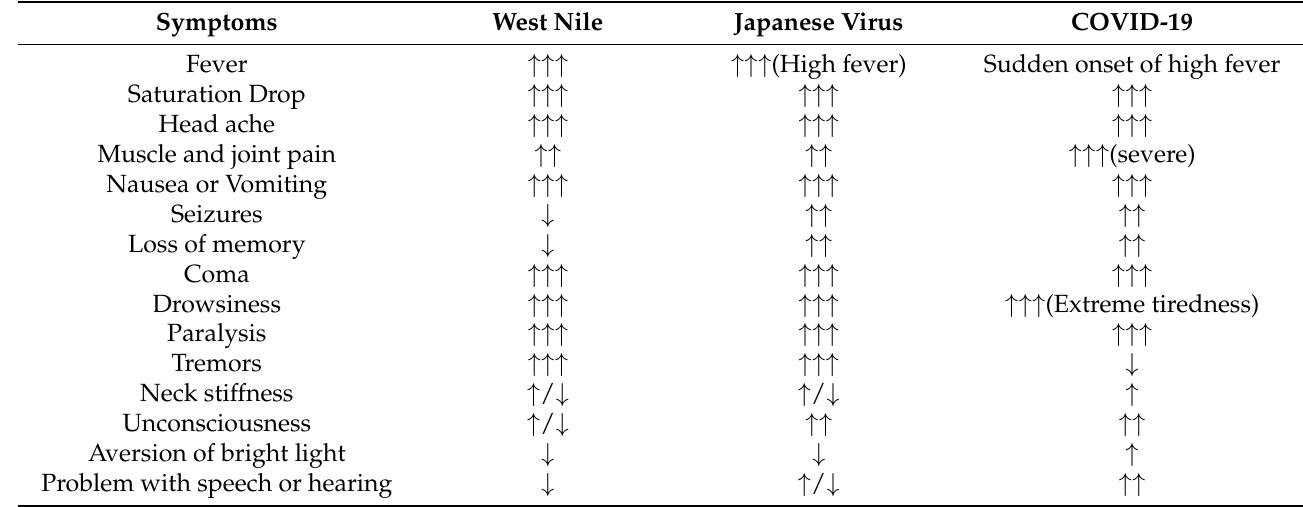
Table 2. Symptoms-based